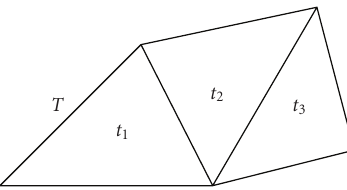
Figure 16: The area of T is the sum of the areas t 1 , t 2 , and t 3